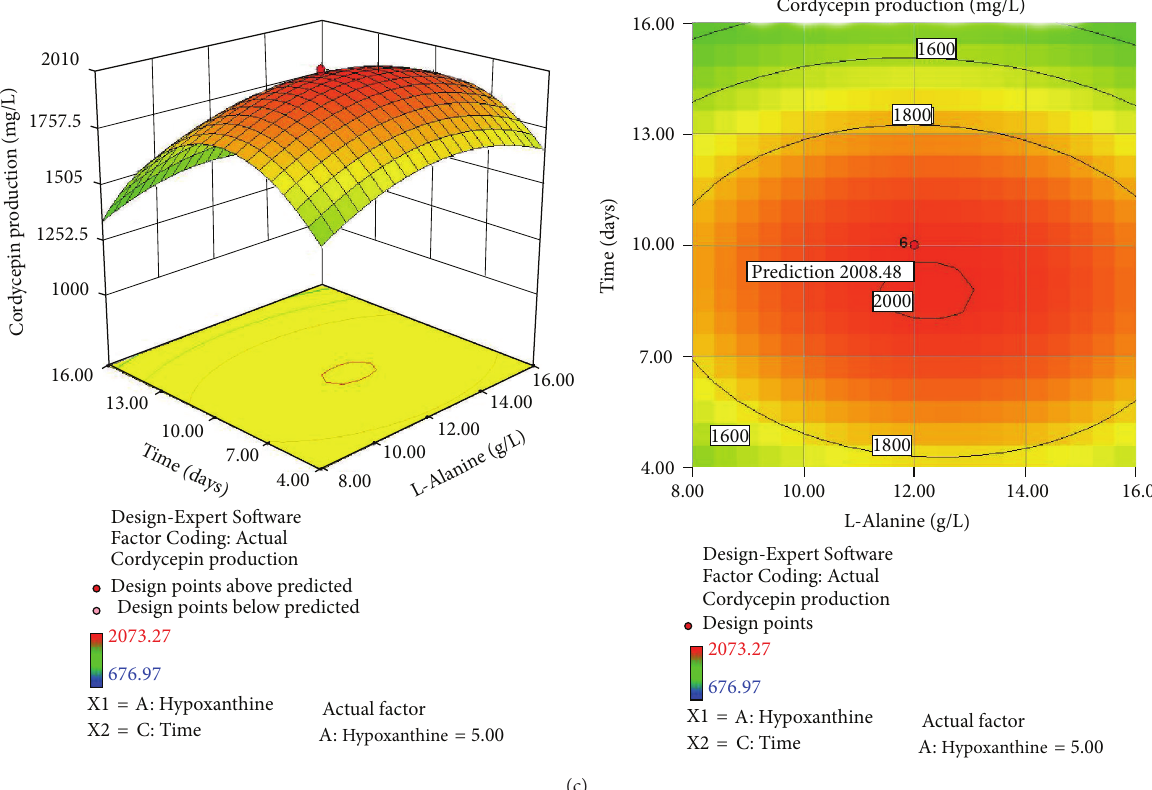
Figure 7: Three-dimensional response surface plots and two-dimensional contour plots for cordycepin production by C. militaris (strain CGMCC2459) showing variable interactions of (a) hypoxanthine and L-alanine; (b) hypoxanthine and time; (c) L-alanine and time.